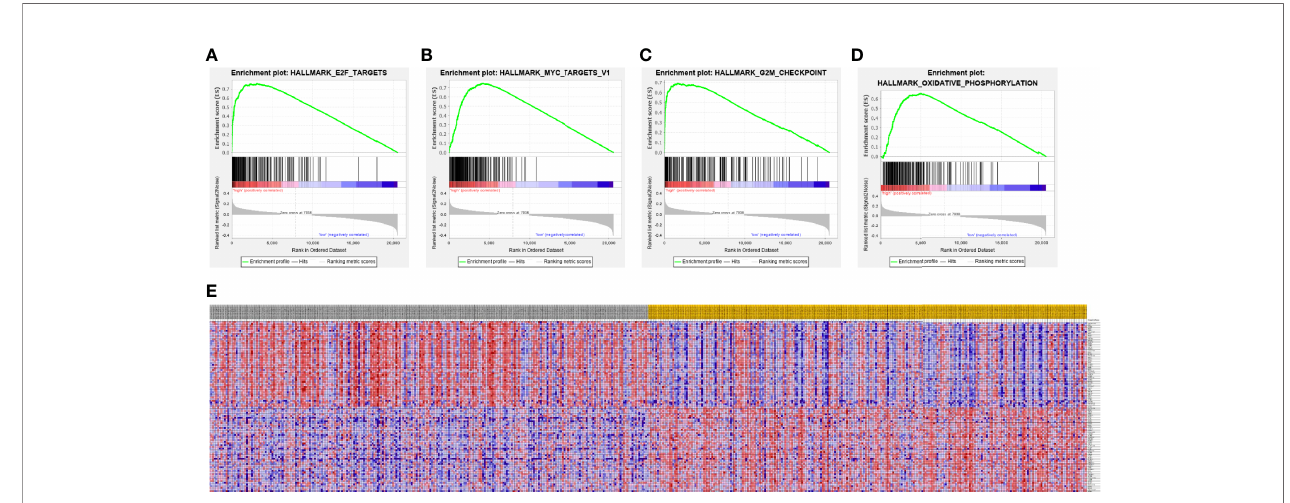
FIGURE 7 | Gene Set Enrichment Analysis according to high expression of heterogeneous nuclear ribonucleoprotein C (HNRNPC). (A – D) The top 4 most signi fi cantly relevant pathways associated with high expression of HNRNPC. (A) E2F targets. (B) MYC targets. (C) G2M checkpoint. (D) Oxidative phosphorylation. (E) Heat map of the top 100 genes signi fi cantly positively or negatively correlated with HNRNPC